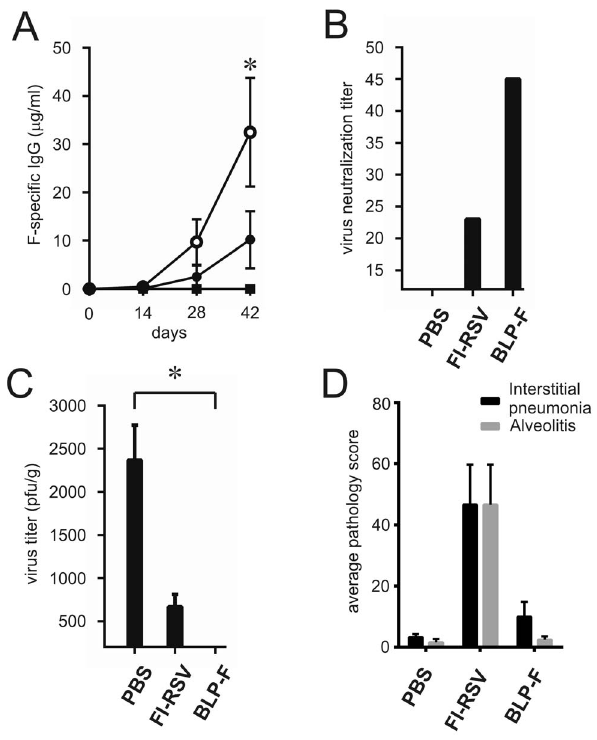
Figure 7. Immunization and challenge studies in mice. Mice N were (mock-)vaccinated three times either intranasally with BLP-F ( # ) ) with 14 day intervals or PBS ( & ) or intramuscularly with FI-RSV ( followed by a challenge with RSV/A/long (10 6 pfu) at 14 days after the last vaccination. A) F-specific IgG titers before immunization (day 0) and 2 weeks after each immunization (days 14, 28 and 42). B) RSV neutralization titers after three immunizations (serum pool of all animals of each group, day 42). C) Virus titers in the lungs at 5 days after challenge. The limit of detection is 200 pfu/gr. D) 5 days post challenge the lungs were harvested for pulmonary histopathology examination. Interstitial pneumonia and alveolitis were scored as described in the Materials and Methods. Standard error of the mean (SEM) is indicated by the error bars. The group receiving BLP-F was compared with the other groups on day 42 using a Mann-Whitney U test (* P # 0.05